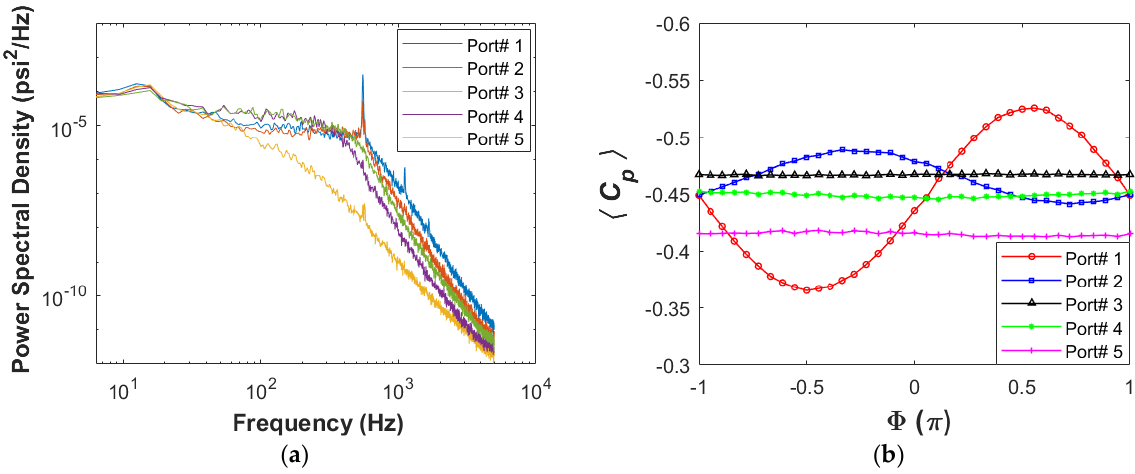
Figure 9. Frequency and amplitude content of the first five dynamic pressure transducers for C µ = 0.11%: ( a ) power spectral density plot; ( b ) phased-averaged pressure distribution.